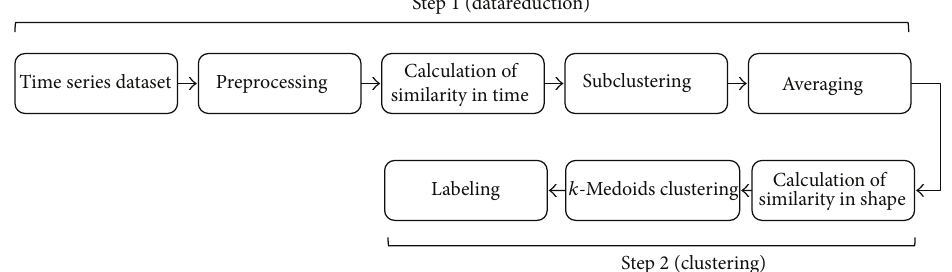
Figure 2: Block diagram for the proposed TTC algorithm.